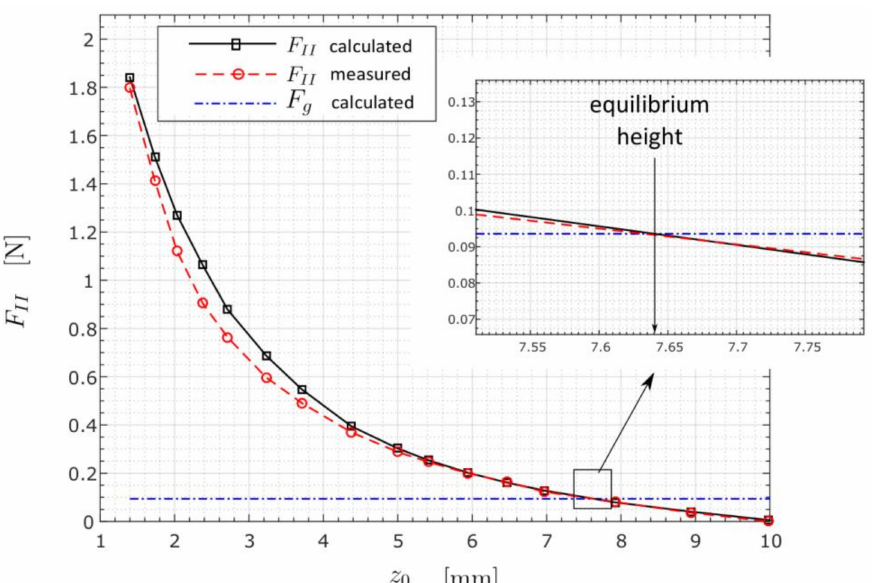
Figure 13. The measured and calculated curves of magnetic levitation force F II for the case r = 2 mm. The force was calculated by the SIM. An intersection between the gravitational F g and mag-netic levitation force F II is shown in the magnified window. Measured data were acquired from ref. [15].